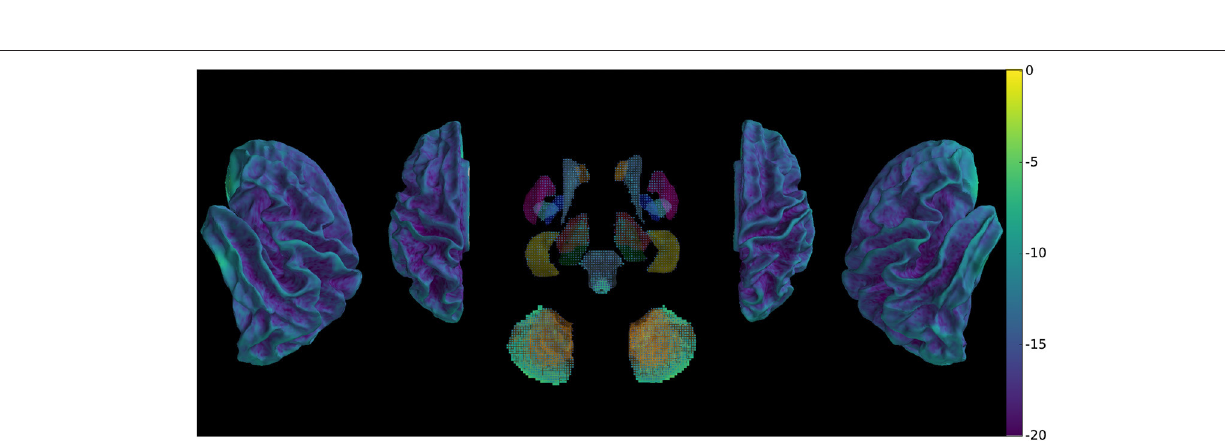
FIGURE 4 | Comparison of betas of BOLD signal regressed with motion parameters (DRMS) using between-preprocessing paired t -test across subjects and scans, showing global decrease of motion explained variance.